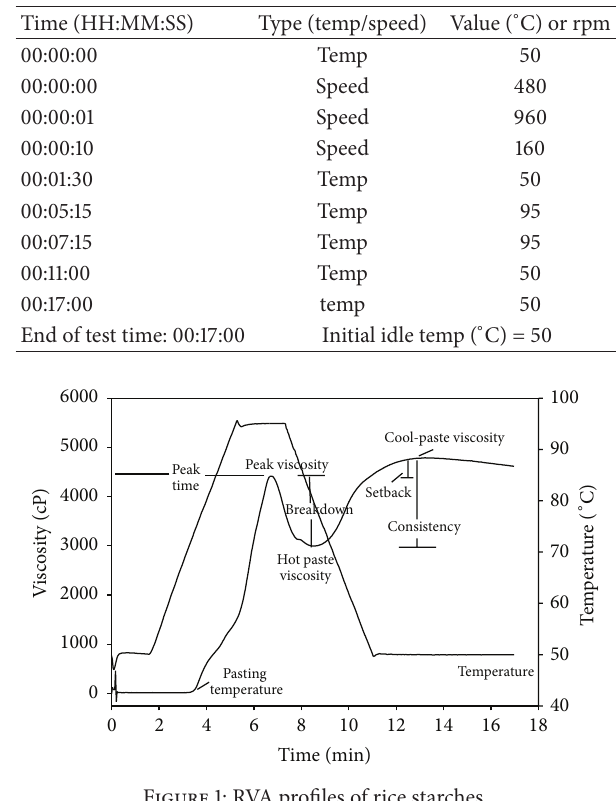
Figure 1: RVA profiles of rice